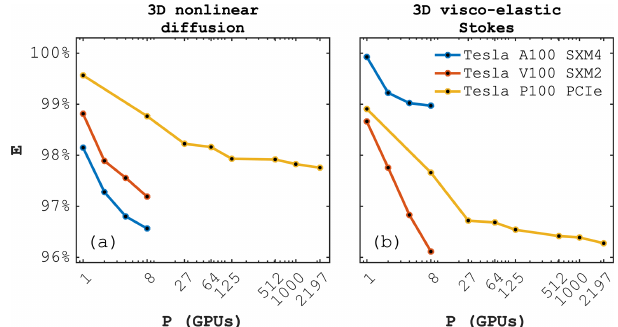
Figure 11. Parallel efficiency E as function of 1–8 Tesla A100 SXM4, 1–8 Tesla V100 SXM2, and 1–2197 Tesla P100 NvidiaGPUs ( P ). Weak-scaling benchmark for (a) the 3D nonlin- ear diffusion solver and (b) the 3D visco-elastic Stokes flow solver based on a 3D Julia implementation using ParallelStencil.jl and Im-